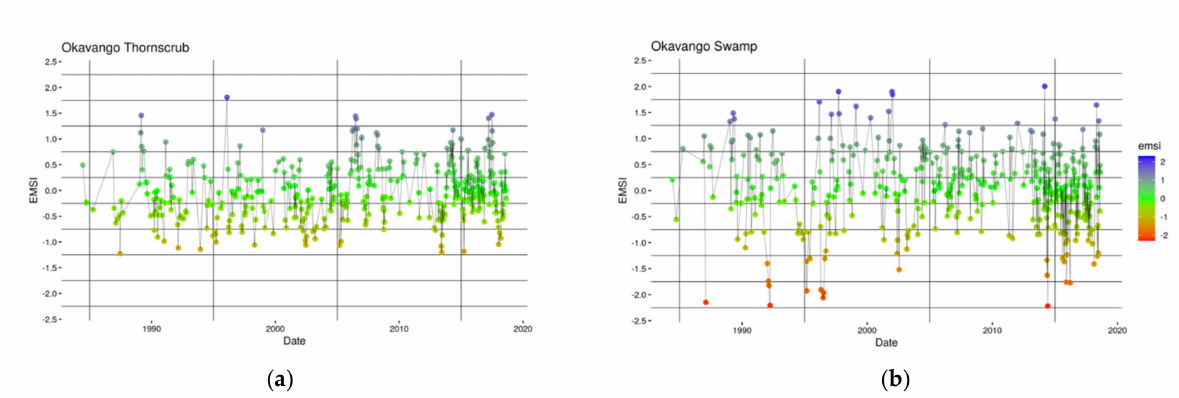
Figure 7. Time series of EMSI for the Okavango example areas ( a ) is the upland site which receives local rainfall and is dominated by herbaceous and woody cover (thornscrub), ( b ) is the lowland site which is swamp-like and fed by the delta, which brings water from neighboring Angola and Namibia watersheds. The variability of EMSI in the swamp site is much wider.